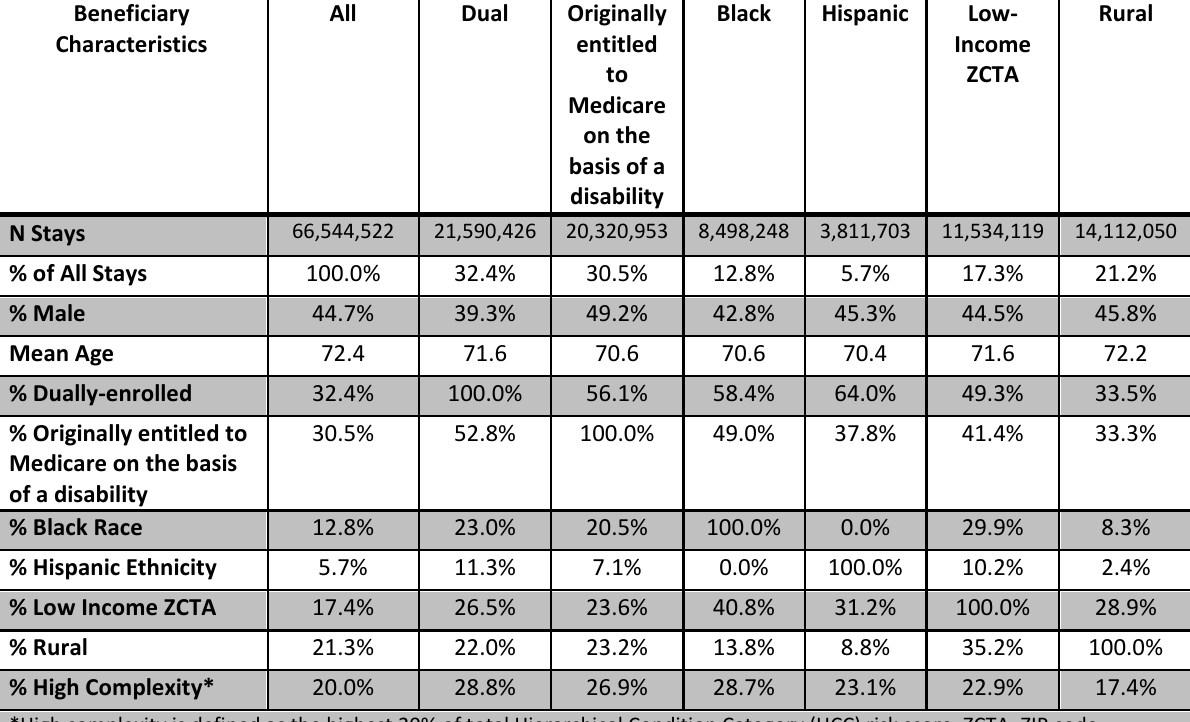
Table 6.3: Beneficiary Characteristics by Social Risk Group